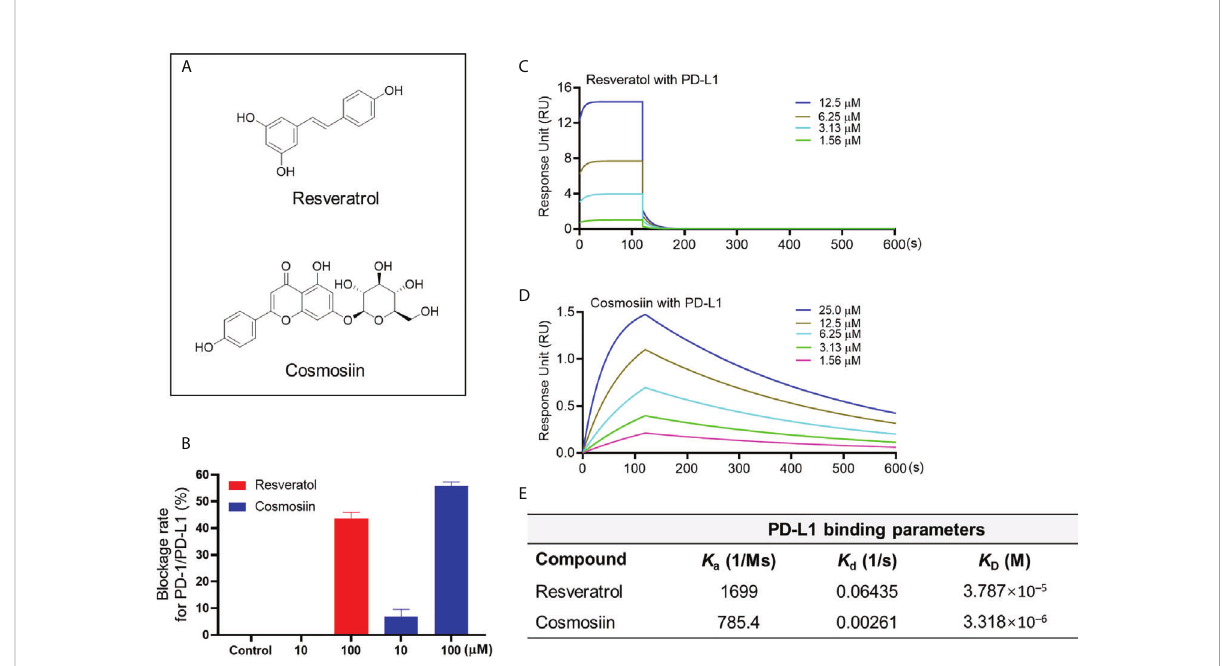
FIGURE 2 Chemical structure of resveratrol and cosmosiin (A) . Blockade rate of resveratrol and cosmosiin (at 10 and 100 m M) on the PD-1/PD-L1 interaction determined by the pair ELISA assay (B) . Binding pro fi le of natural compounds at various concentrations with PD-L1 protein characterized by the SPR measurements. Sensograms of resveratrol with PD-L1 (C) protein at 1.56-12.5 m M. Sensograms of cosmosiin with PD-L1 (D) protein at 1.56-25 m M. Summarized binding parameters including Ka, Kd, and K D between test compounds and PD-L1 proteins (E)